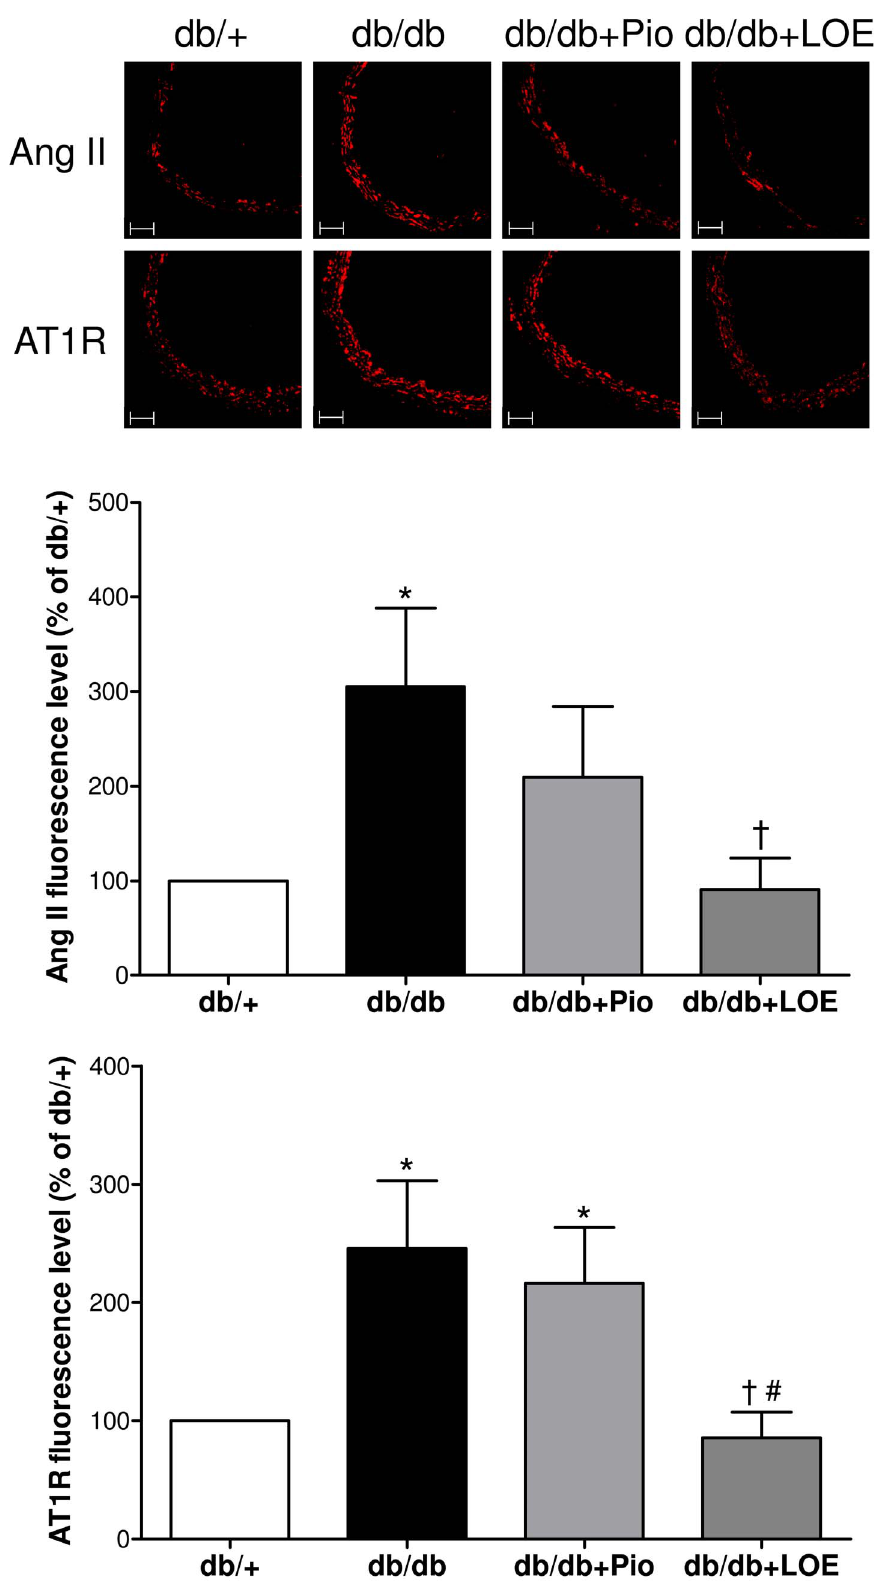
Figure 5. Effect of LOE and pioglitazone treatments on the expression of angiotensin II (Ang II) and angiotensin II type 1 receptors (AT1R) in aortic sections of db/db mice. The expression of Ang II and AT1R was assessed by immunofluorescent staining. Top: representative immunofluorescent staining; bottom: corresponding cumulative data. The lumen is on the right side of each image, and the scale bar corresponds to